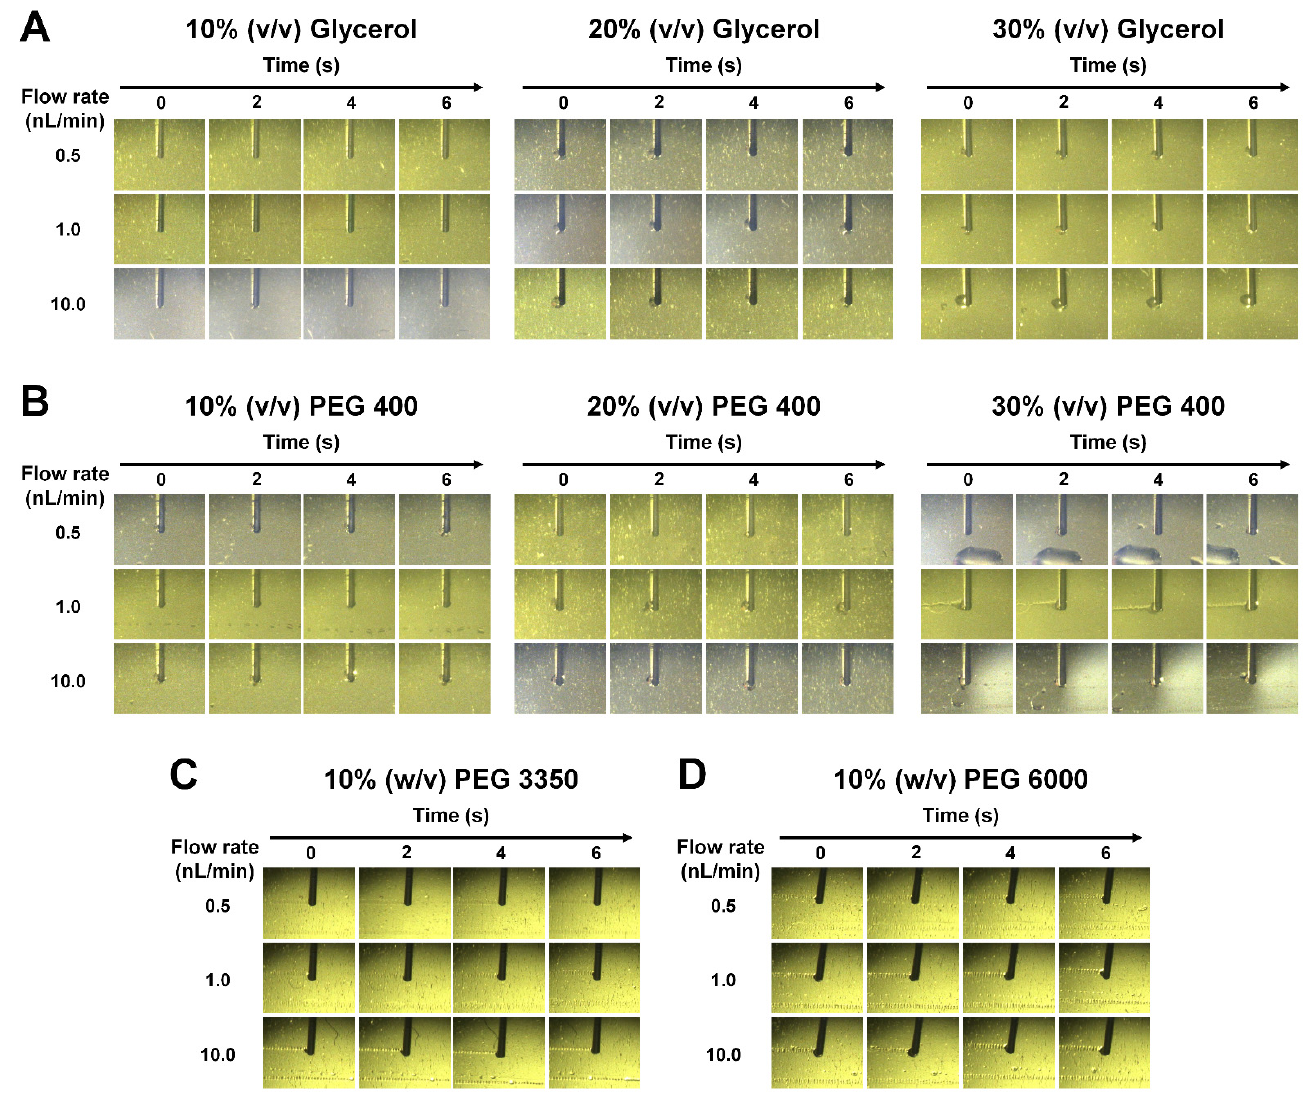
Figure 3. Injection experiment with viscous solutions on polyimide film in BITS: ( A ) 10–30% ( v/v ) glycerol solution; ( B ) 10–30% ( v/v ) PEG 400 solution; ( C ) 10% ( w/v ) PEG 3350; and ( D ) 10% ( w/v ) PEG 6000 solutions.